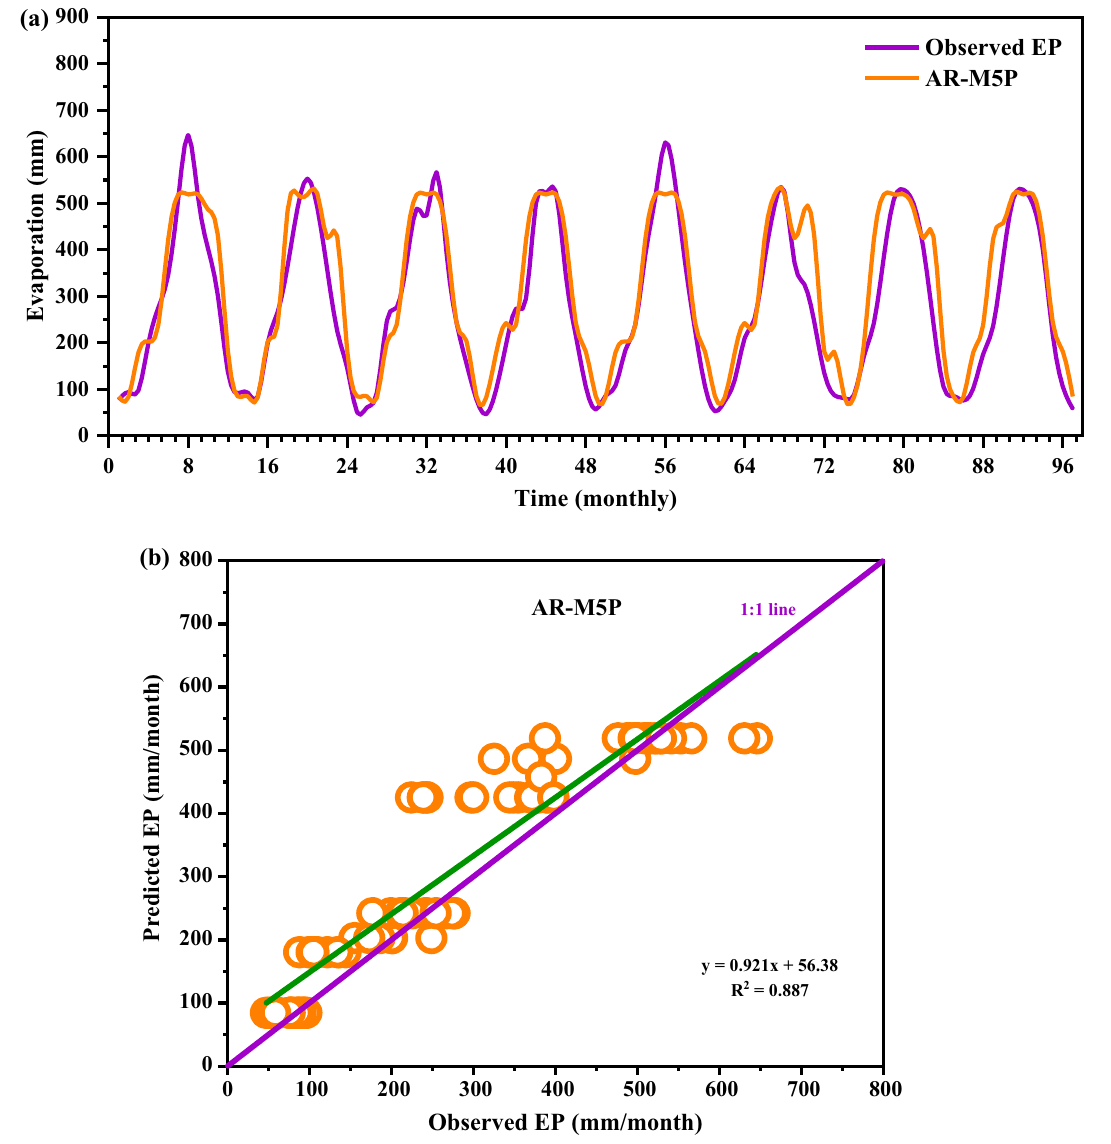
Fig. 11 Observed vs estimated daily evaporation values by the best model AR-M5P during validation at Basrah station: a temporal variation; b scatter